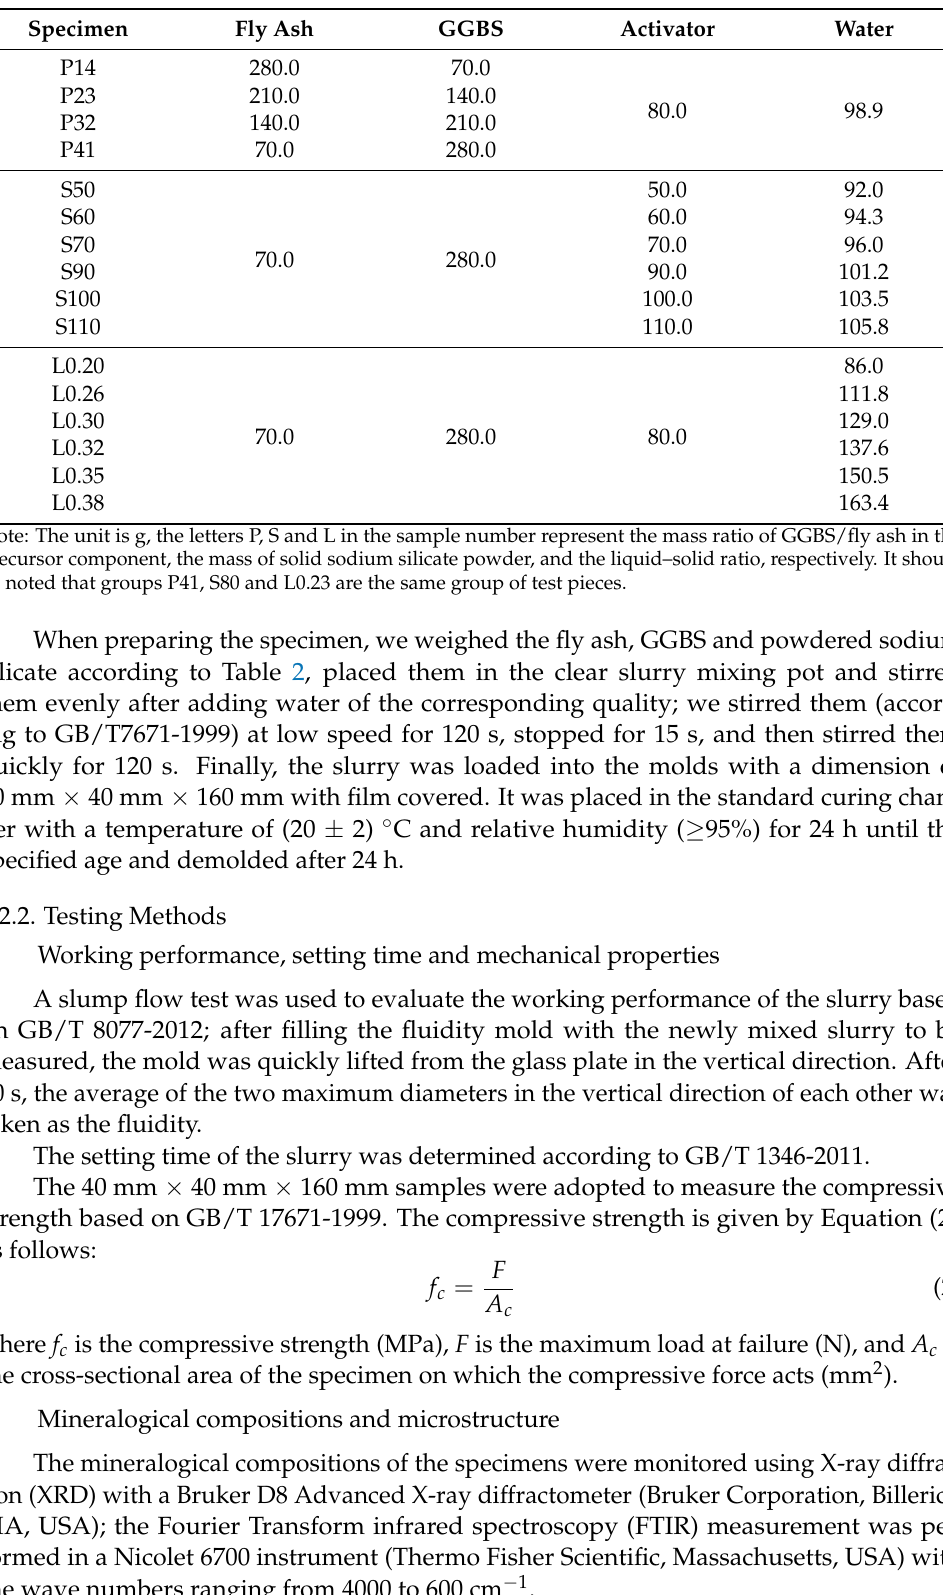
Table 2. Mix proportions of GGBS/fly ash